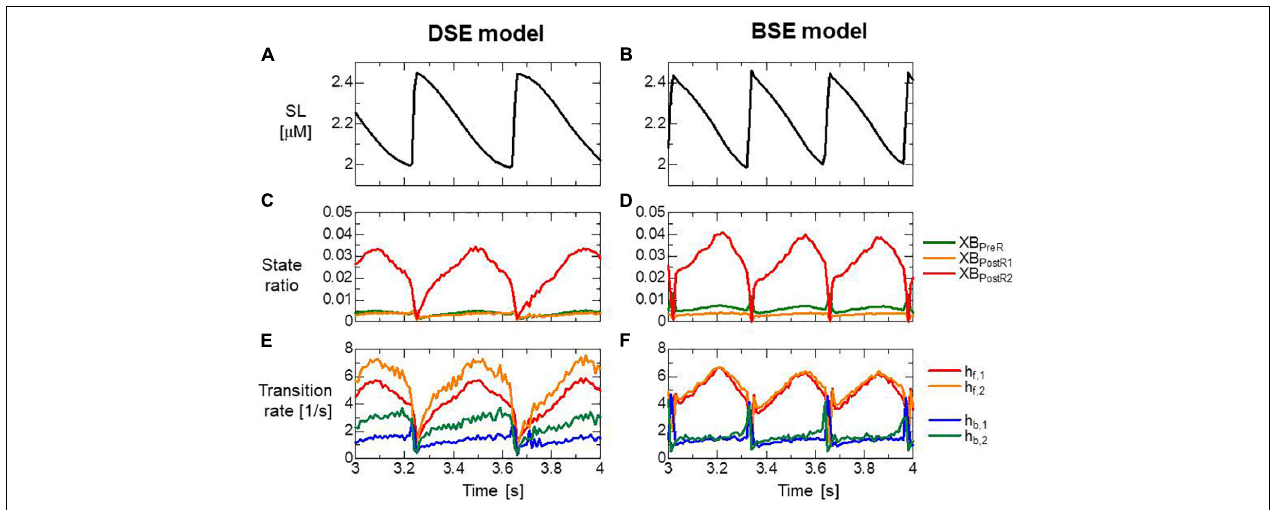
FIGURE 11 | (A,B) Time transients of the sarcomere length (SL), (C,D) ratio of binding states, and (E,F) transition rates between the binding states for the half-sarcomere model imbedded at the center of the myofibril model consisting of 20 sarcomeres during the SPOC with [Ca 2 + ] = 0.3 µ M. Panels (A,C,E) and panels (B,D,F) are the results of the DSE and BSE models, respectively. (E,F) Transition rates were calculated by dividing the total number of transitions per unit time by the total number of myosin molecules.